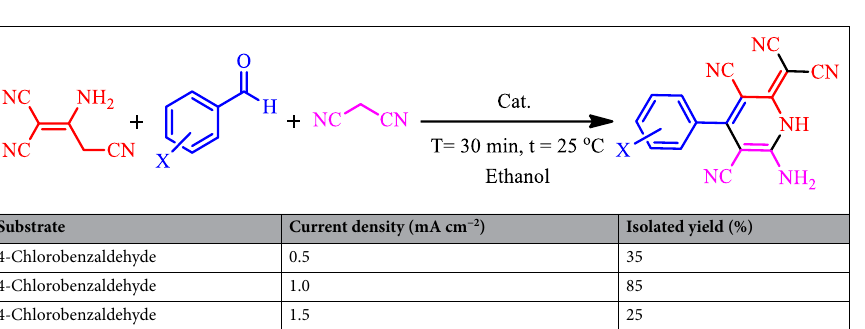
Substrate Current density (mA cm −2 ) Isolated yield